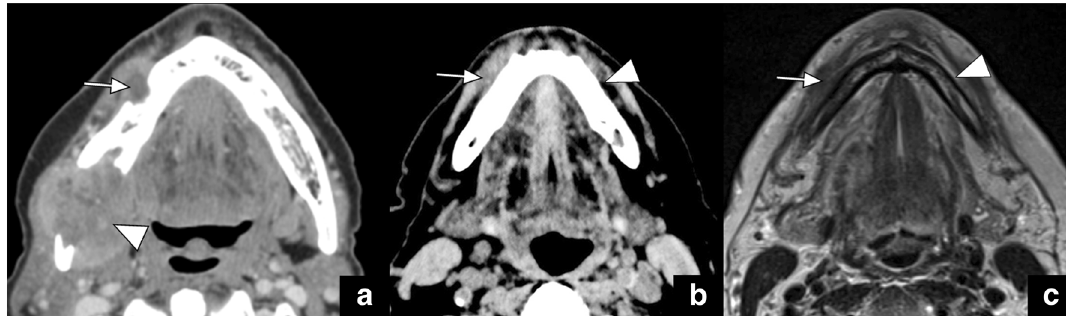
Fig. 5 Axial CT image ( a ) in a patient with lower face numbness reveals obliteration of the fat pad at the right mental foramen at the expected location of the mental nerve ( long arrow in a ) with a large primary tumour seen at the right retromolar trigone ( arrowhead in a ). This is an example of antegrade PNTS. Axial CT ( b ) and T1-weighted ( c ) images in